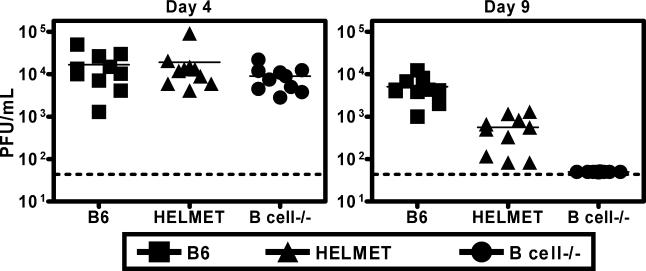
HEL-Specific B Cells Restore Acute Phase γHV68 Replication to the B Cell−/− BackgroundSplenic viral titer measured at days 4 and 9 after γHV68 infection. Solid lines represent the mean viral titer. Dotted lines represent the limit of detection of the assay. Each symbol represents the viral titer in a single mouse. Data were pooled from two independent experiments.